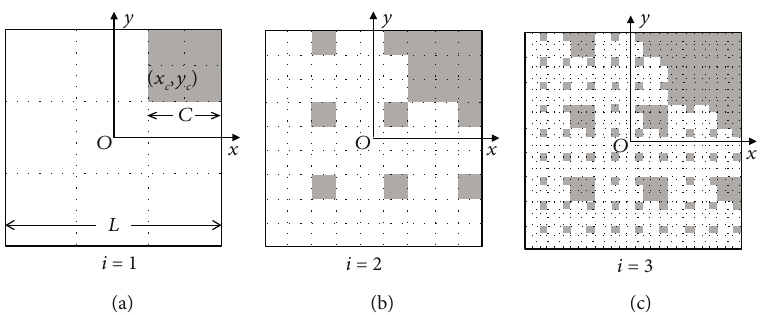
Figure 1: A schema for the construction process of the 2D Sierpinski carpet with s = 3 , n = 1 , ε (white and gray areas represent solid and pore phases, respectively). Table 1: Parameters of the isotropic Sierpinski carpet models. Group no. s